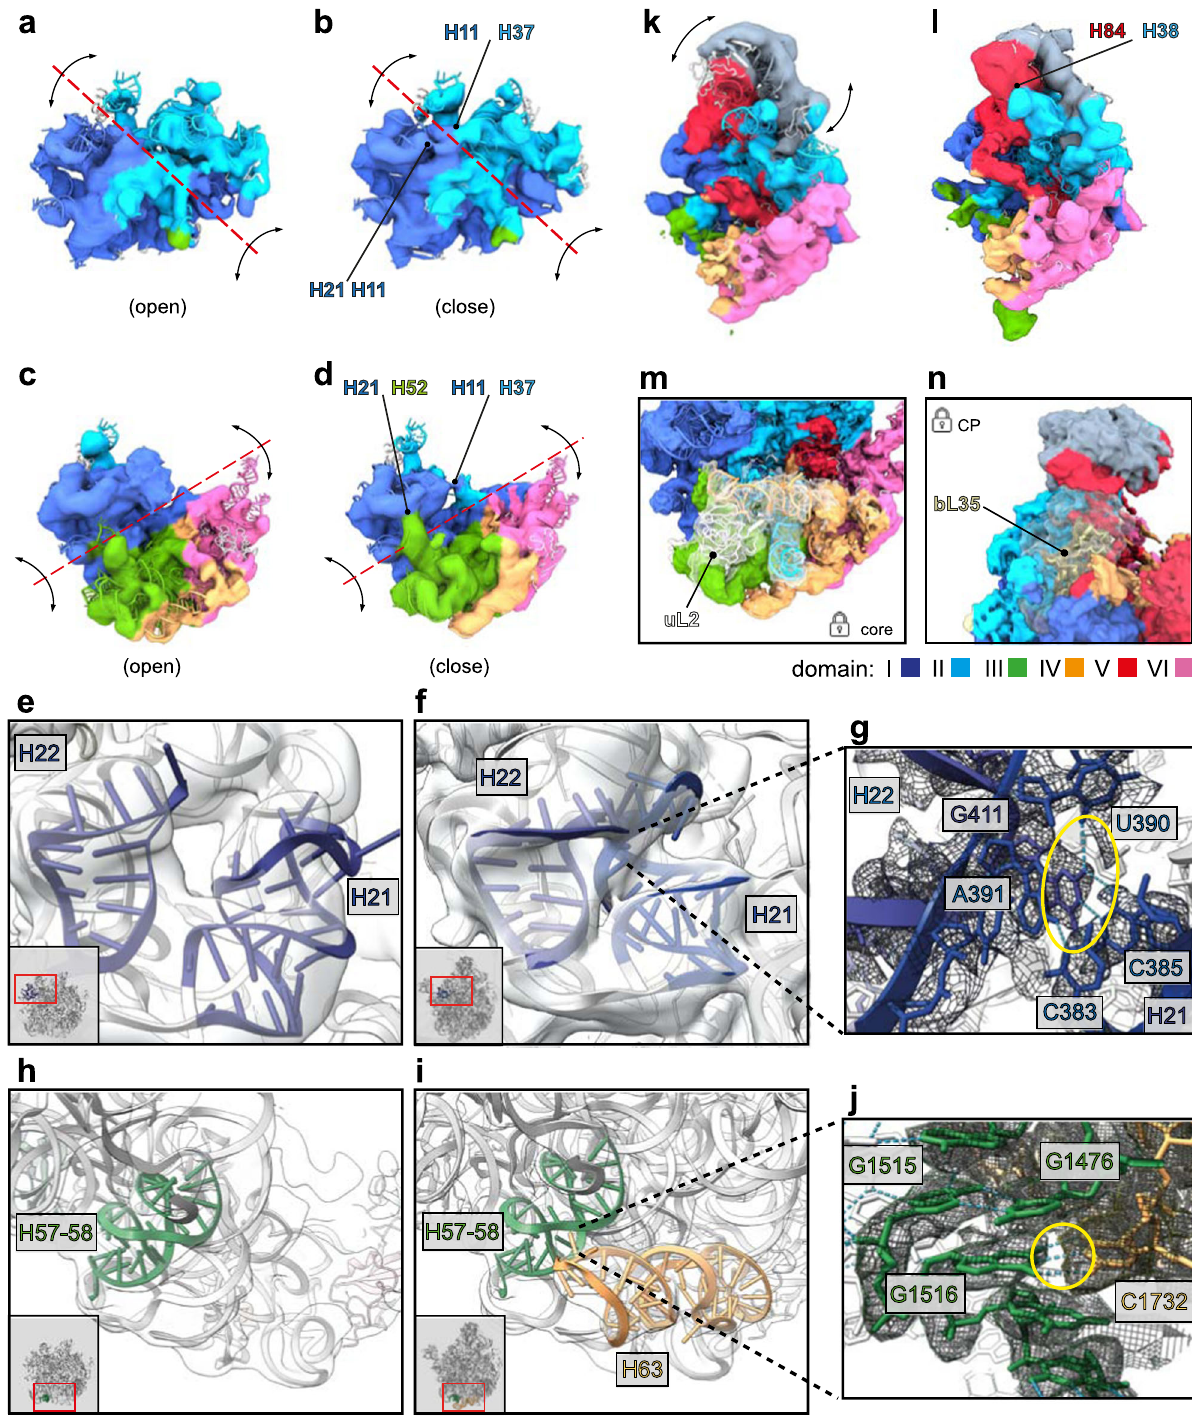
Fig. 5 | Tertiary contacts between rRNA helices. 3D variability maps of states d12 ( a , b ), d136 ( c , d ), d126-CP ( k , l ). First (left) and last (right) reconstructed frame of eachstate isshown.Mapswere fi lteredto8Åand color-coded accordingto the six architecturaldomainsof23SrRNA.Red dotted linesand blackarrows indicate axis and directions of observed globalmovements, respectively. Stabilizing contacts in closed conformations are indicated by black arrows. Interacting regions are labeled.Cryo-EM maps(transparent gray)and PDB modelscorresponding to rRNA helices H21 and H22 (blue), H57-58 (green), or H63 (orange), respectively. Local